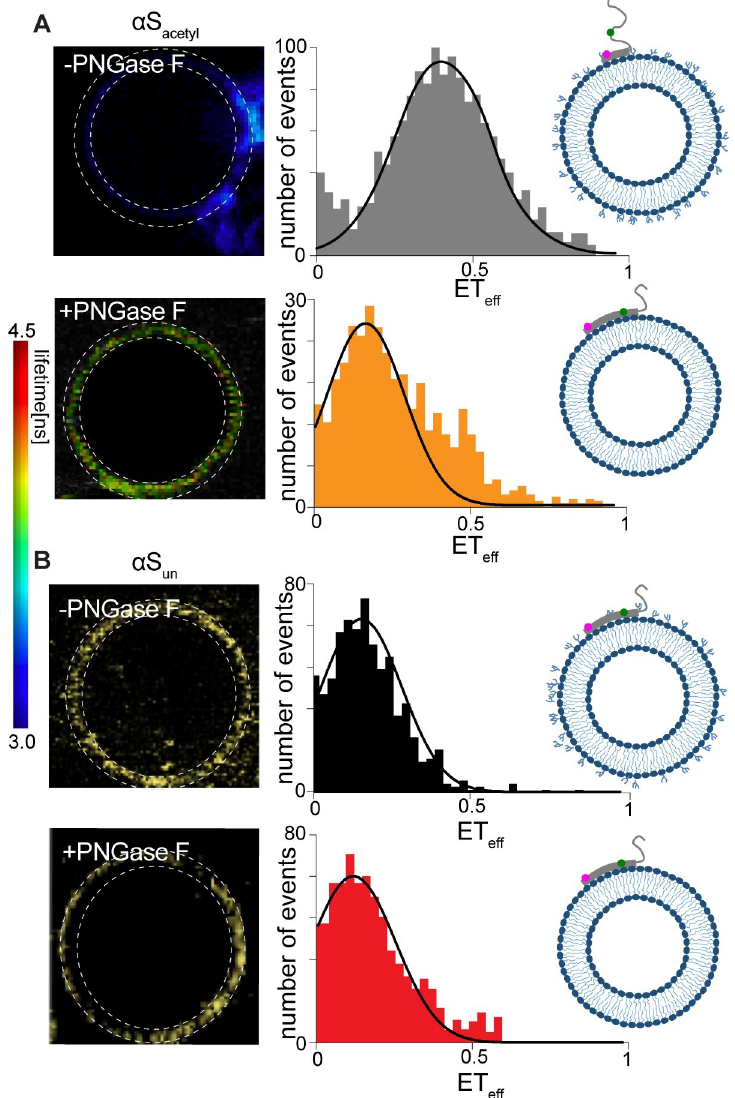
Fig 5. Intramolecular FLIM-FRET measurements of α S bound to SH-SY5Y GPMVs. (A) FLIM-FRET measurements of α S acetyl bound to GPMVs without (upper) and with (lower) treatment with PNGase F. Left: representative image of a GPMV, colored by donor fluorophore lifetime shown in the scale bar. Right: histogram of ET eff calculated from the images, with Gaussian fits shown. The pixels used to calculate the histograms are indicated by dashed lines on the GPMV images. (B) As in (A) but with α S un. Histograms indicated are an average of 3 GPMVs per biological replicate ( n = 3). The underlying data for this figure can be found in S1 Data. α S, α -Synuclein; α S acetyl , N- terminally acetylated α S; α S un , unmodified α S; ET eff , energy transfer efficiency; FLIM, fluorescence lifetime